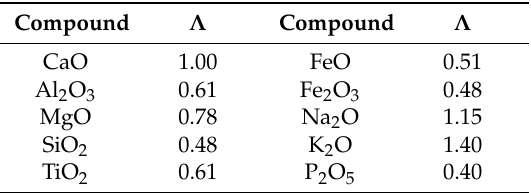
Table 6. Optical basicity of the oxides in red mud.